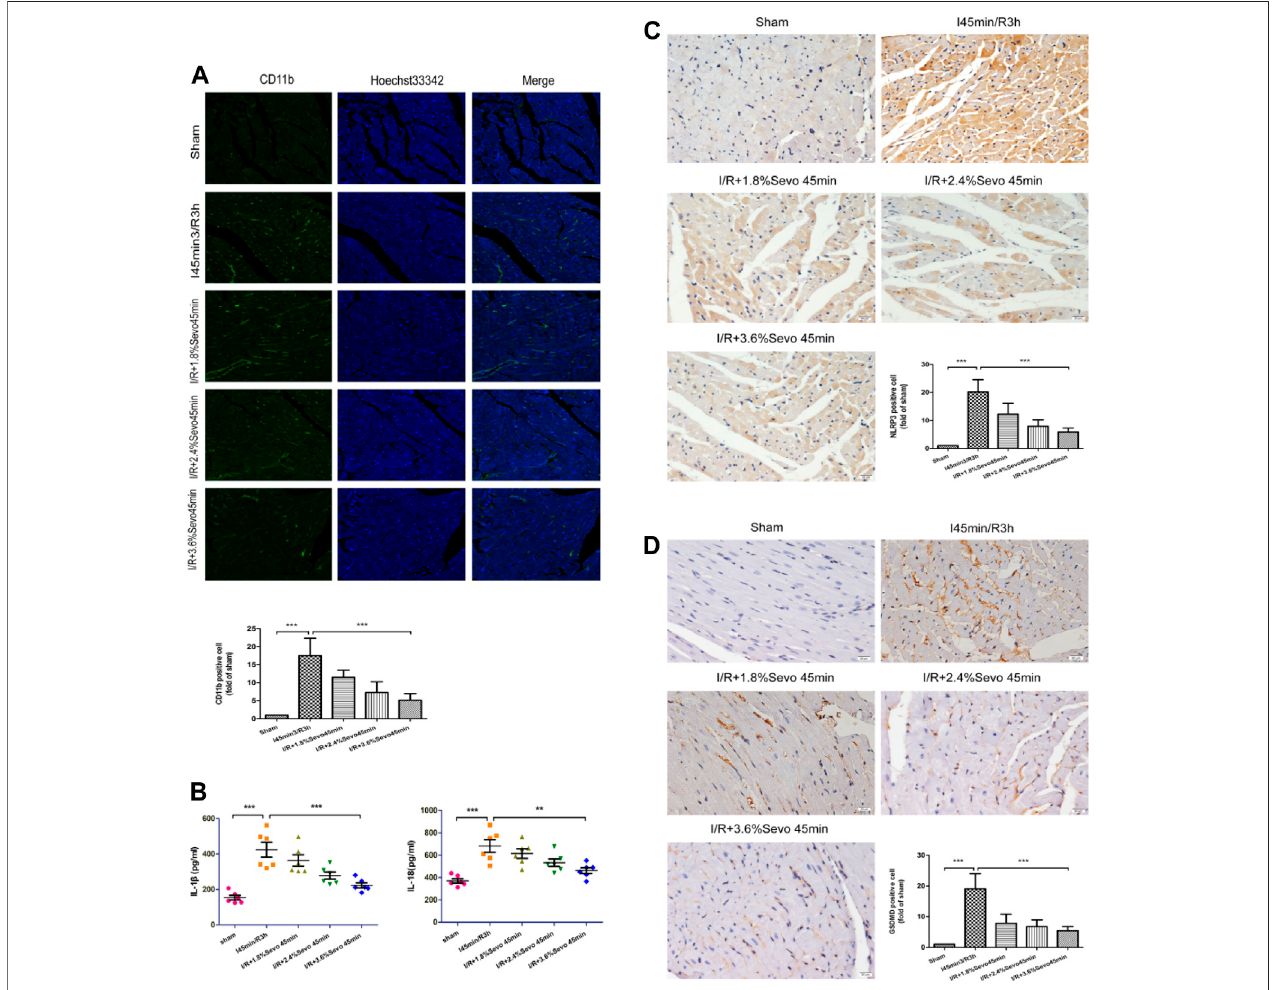
FIGURE4| Sevo fl uranealleviatesin fl ammatorycellin fi ltrationinMIRIrats (A) TheexpressionofCD11binratmyocardialtissuedeterminedbyimmuno fl uorescence staining (n (cid:1) 6,Scale bars 20 um) (B) Effects of Sevo fl urane at different concentrations on the release of IL-1 β and IL-18 in myocardial tissue after MIRI. All values are expressed as means ± SD (n (cid:1) 6). * p < 0.05, ** p < 0.01, *** p < 0.001 vs respective controls (C) Expression of NLRP3 in rat myocardial tissue by immunohistochemical staining of normal perfusion, MIRI and sevo fl urane treatment with different concentrations in rats (n (cid:1) 6,Scale bars 20 um) (D) The Expression of GSDMD in rat